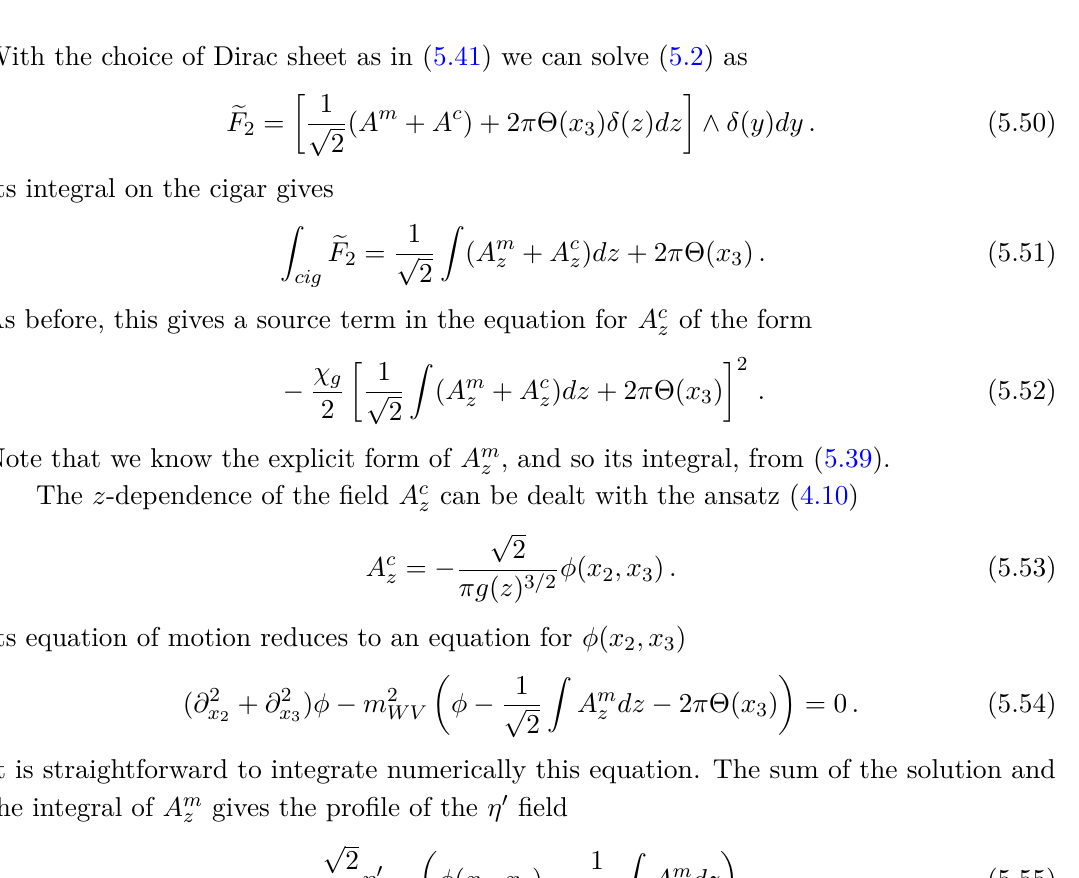
Table 2 . Summary of parametric dependence of tension and thickness of the core and shell parts of the vortex loop (string). For the reader’s convenience, we used the dynamical scale notation Λ instead of M . R is a large-distance KK c